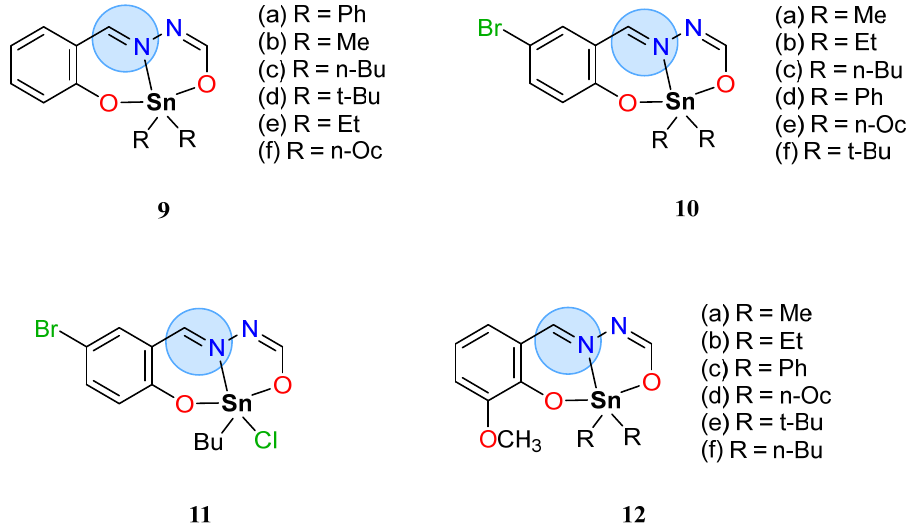
Figure 6. Organotin(IV) complexes with tridentate Schiff base ligands (ONO) tested for antileishmanial activity.